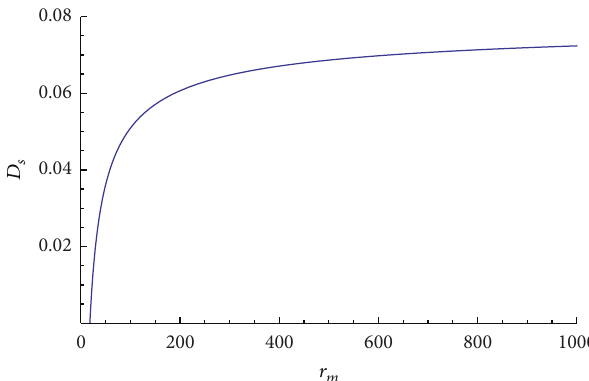
Figure 3: The RG flow of the momentum diffusion constant, where we take 𝜂 = 1 , 𝑇 𝐻 = 1 , and 𝐷 = 4 . Similarly to the charged diffusion constant, the momentum diffusion constant also increases monotonically with the energy scale 𝑟 𝑚 , and it becomes zero at the horizon 𝑟 ℎ = 18.2521